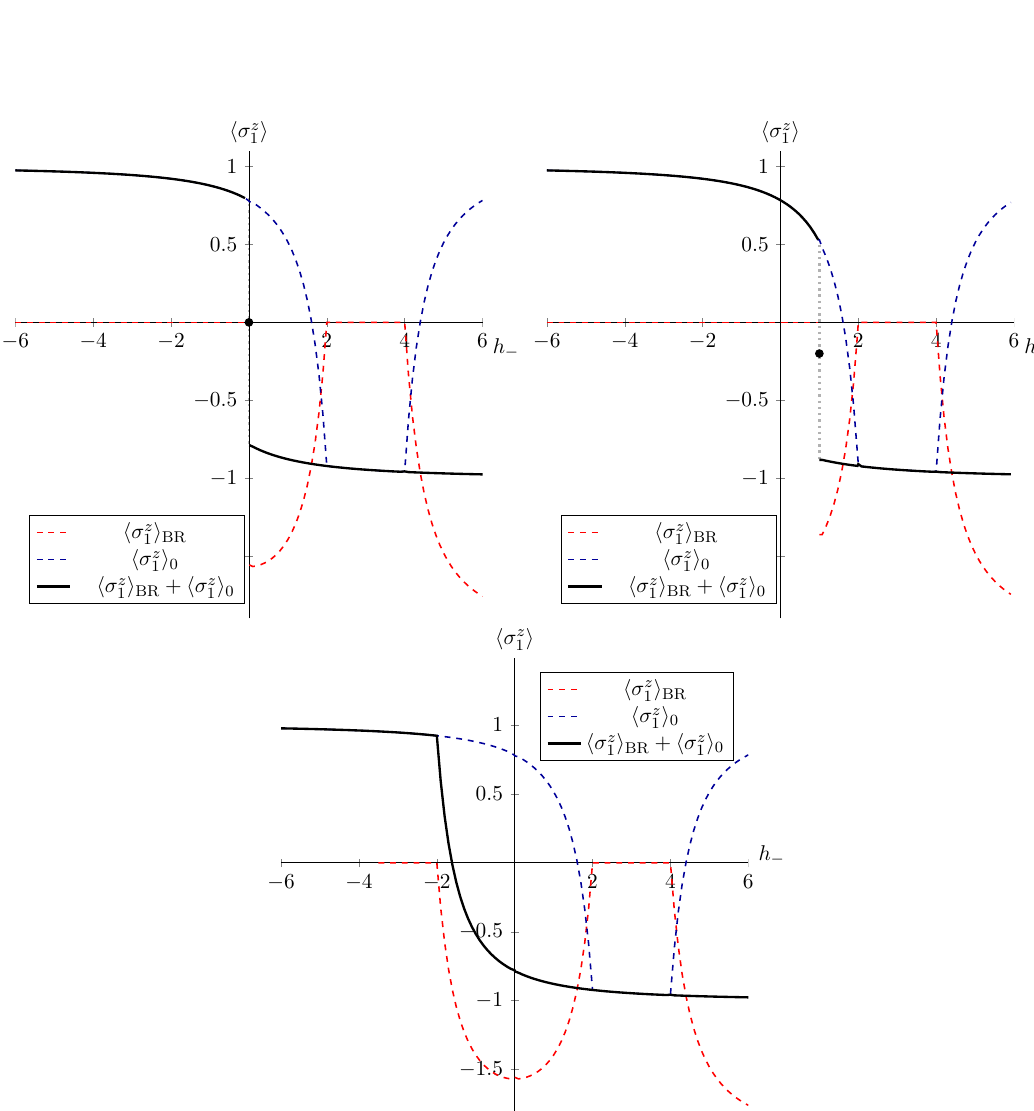
〉 in the thermodynamic 1 〉 , while the red 0 1 〉 . The sum of the two is BR 1